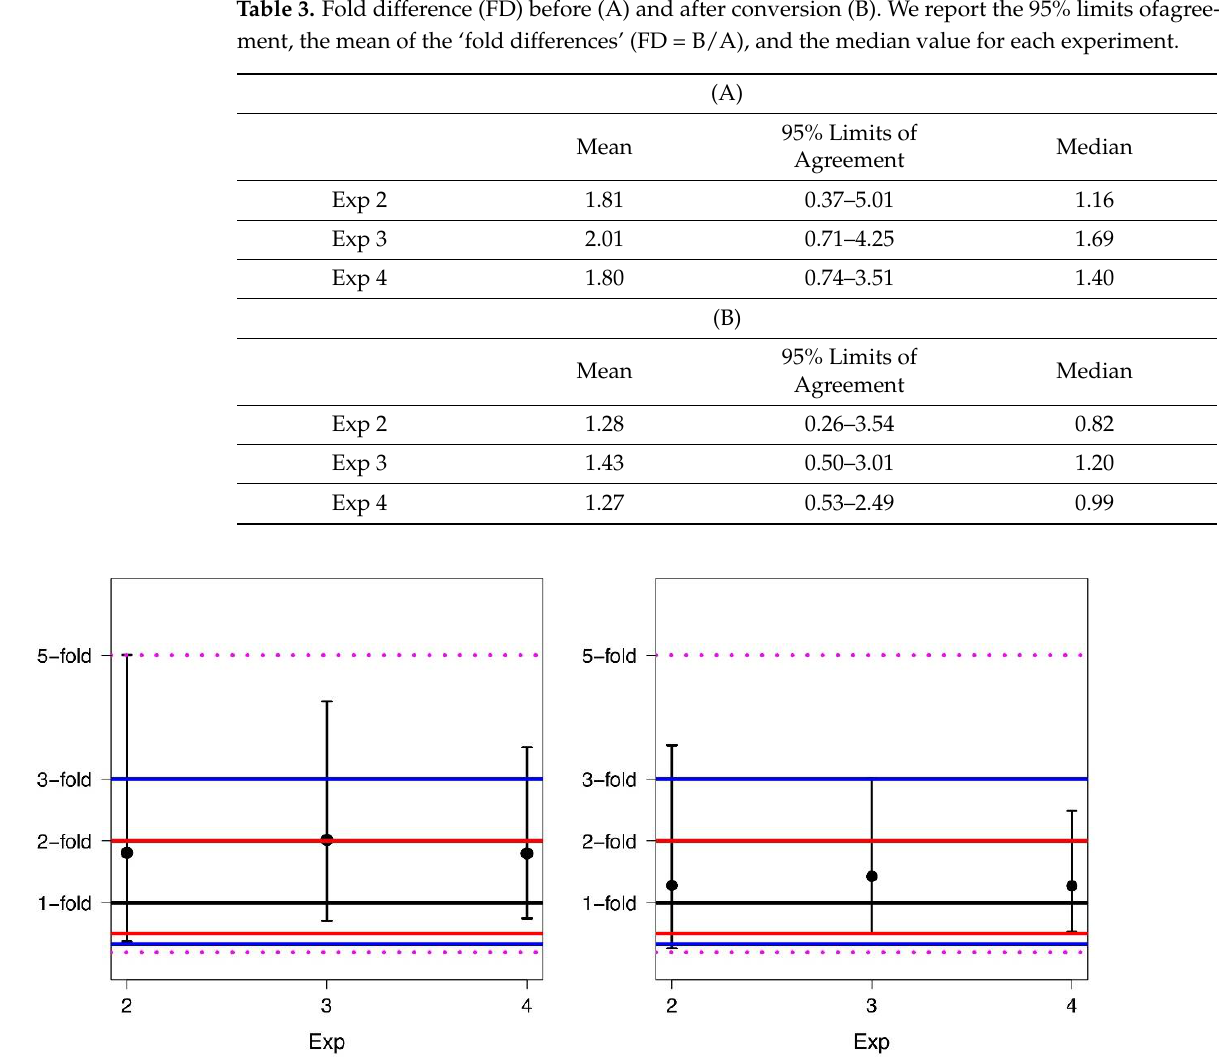
Figure 4. Means and corresponding 95% limits of agreement of the fold differences for Exp2, Exp3, and Exp4 before conversion ( left panel) and after conversion ( right panel).